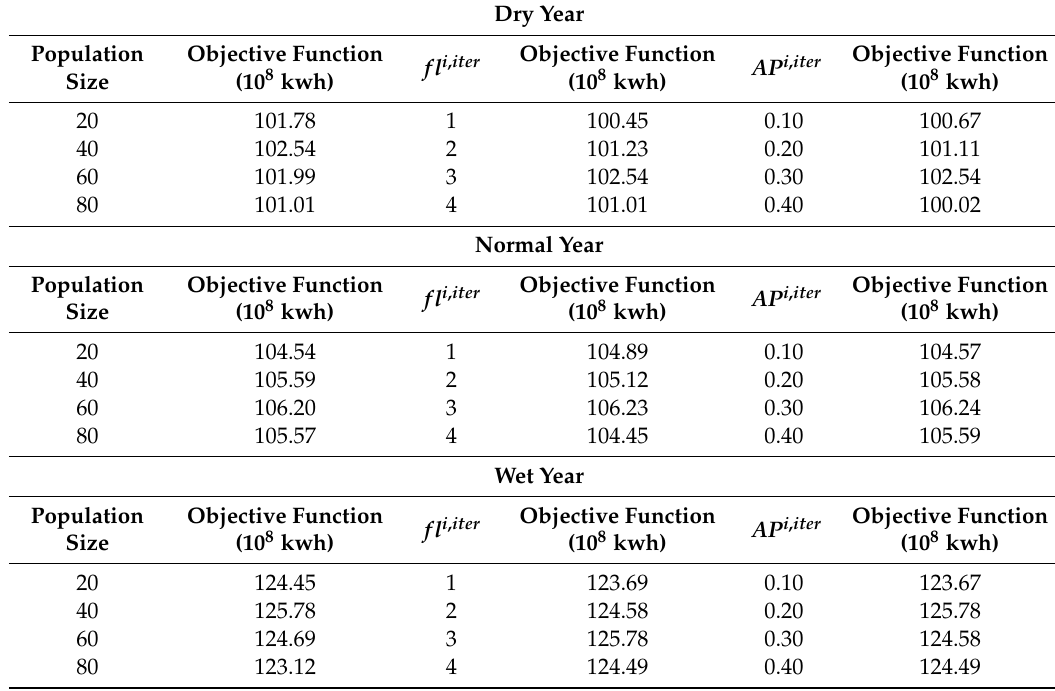
Table 3. Sensitivity analysis for di ff erent algorithms for dry years, normal years, and wet